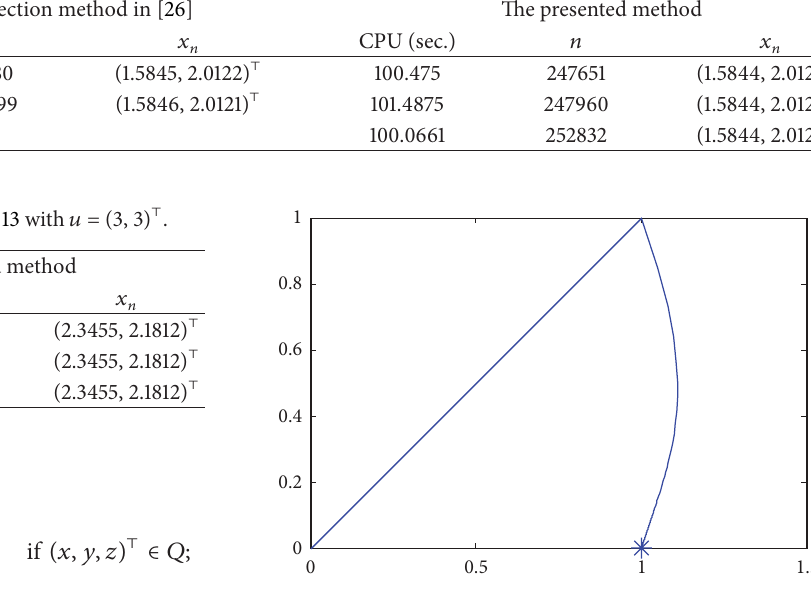
Figure 1: The behavior of our presented algorithm to search the common minimal point of two convex minimization problems. The star sign marks the stop point, ̃𝑥 , of the